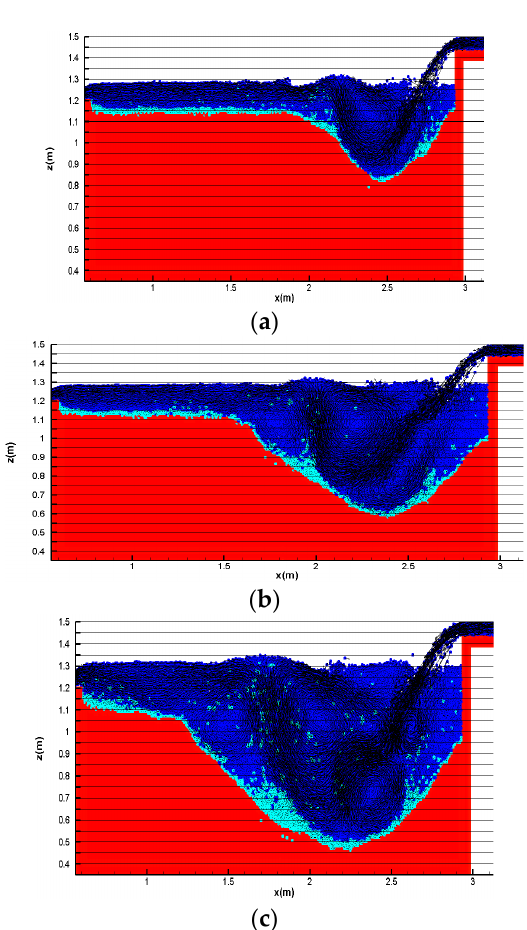
Figure 2. Snapshots of incompressible smoothed particle hydrodynamics (ISPH) calculated equilibrium scouring pit with different overflow depth: (a) η = 3.3 cm; (b) η =4.7 cm, and (c) η =6.0 cm.